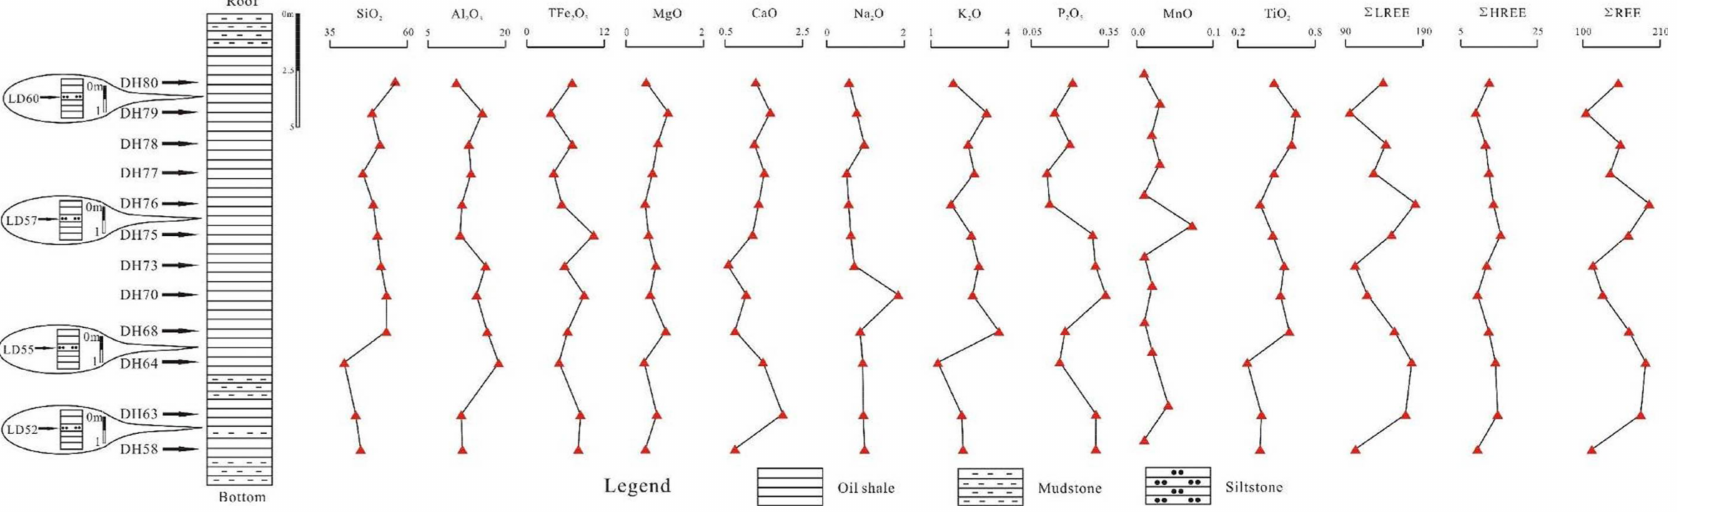
Figure 2. Vertical variation of major elements and rare earth elements of oil shale samples (unit of major elements and rare earth elements in wt % and ppm,